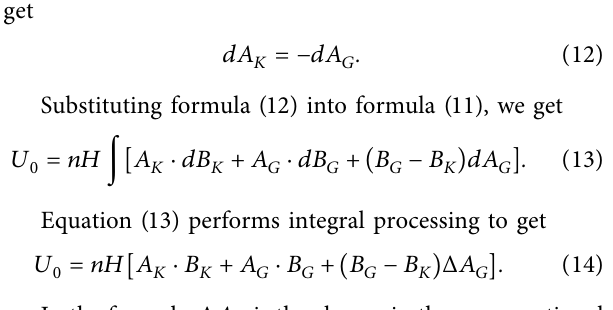
Figure 5: Isomagnetic